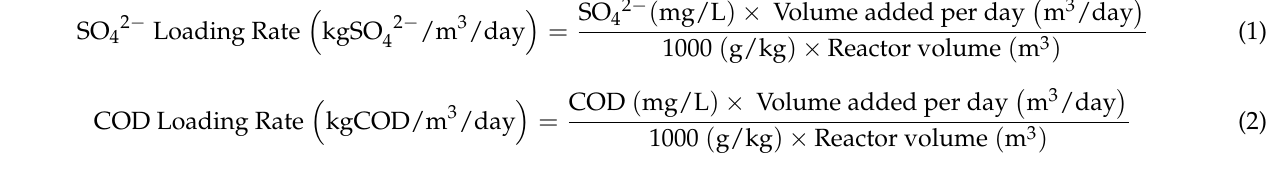
Table 4. Operational protocol—sulphate and COD loading